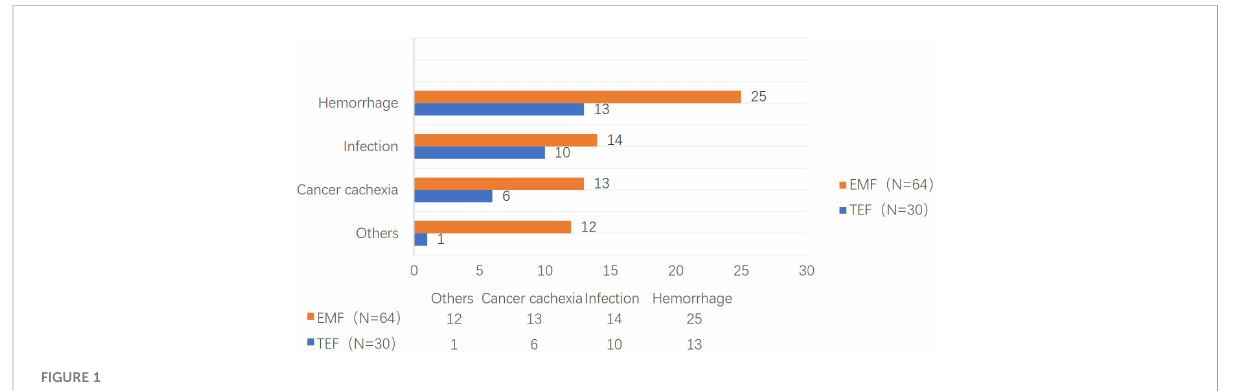
FIGURE 1 The causes of death of TEF and EMF groups.